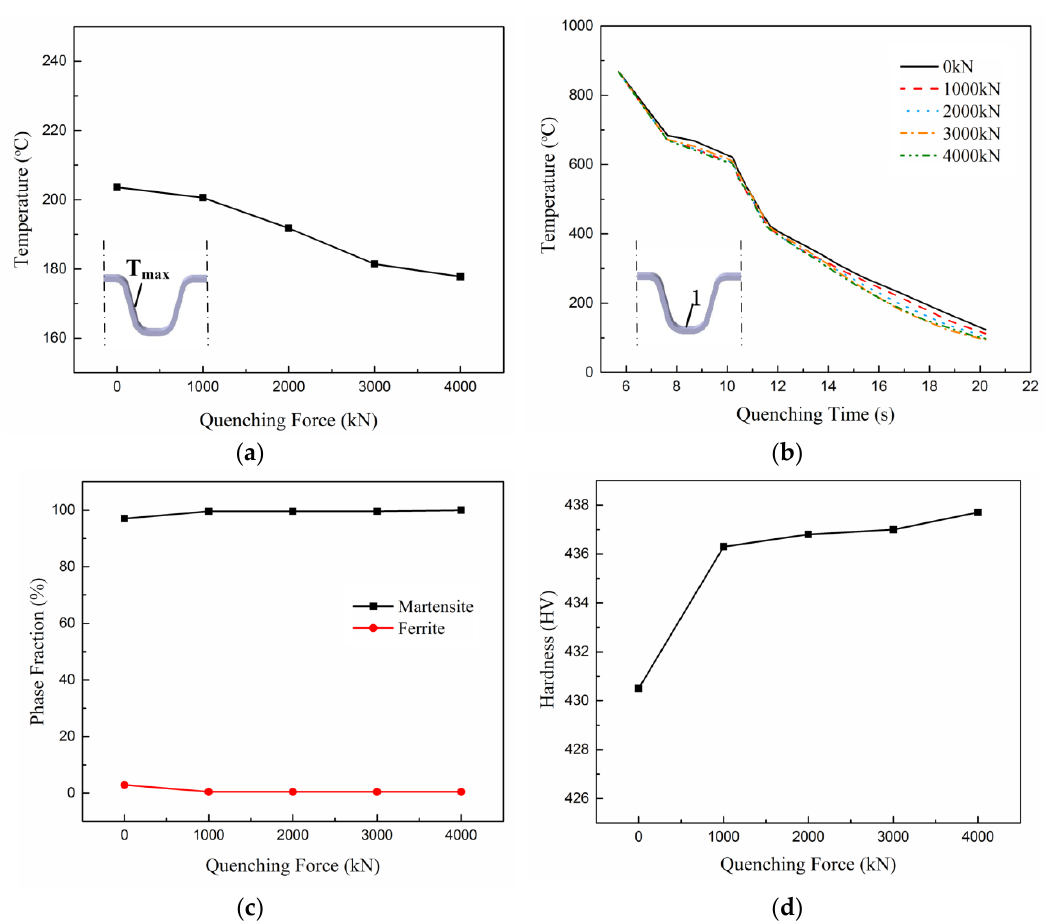
Figure 5. Variation of the maximum temperature ( a ), temperature histories ( b ), phase fractions ( c ), and minimum hardness with the quenching forces ( d ). and minimum hardness with the quenching forces ( d ).